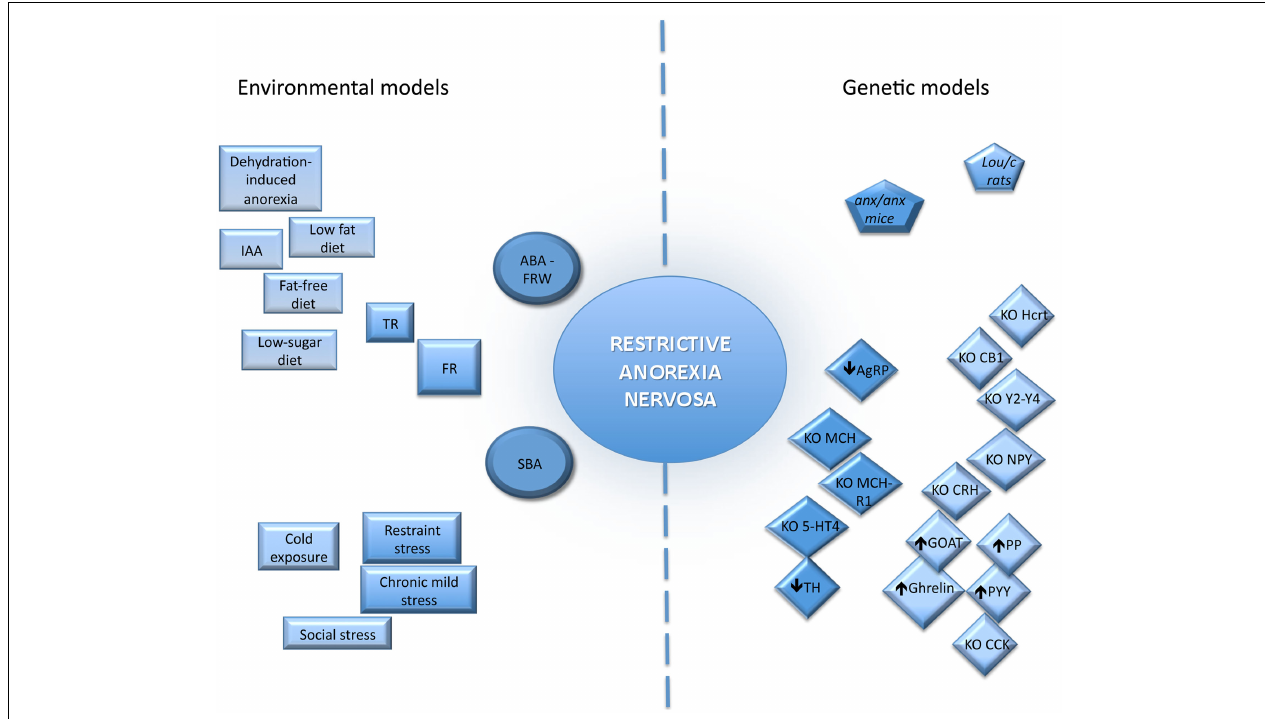
out (KO), transgenic ( " ), specific deletion ( # ). ABA, activity based anorexia; AgRP, agouti related peptide; CB1, cannabinoid receptor type 1; CCK, cholescystokin; CRH, corticotropin releasing hormone; FR, food restriction; IAA, indispensable amino acid deficient diet; GOAT, ghrelin O-acyltransferase; Hcrt, orexin/hypocretin; MCH, melanocortin concentrating hormone; NPY, neuropeptide Y; PP, polypancreatic peptide; PYY, peptide YY; SBA, separation based anorexia; TH, tyrosine hydroxylase; TR, time-restricted feeding; 5-HT R, serotonin